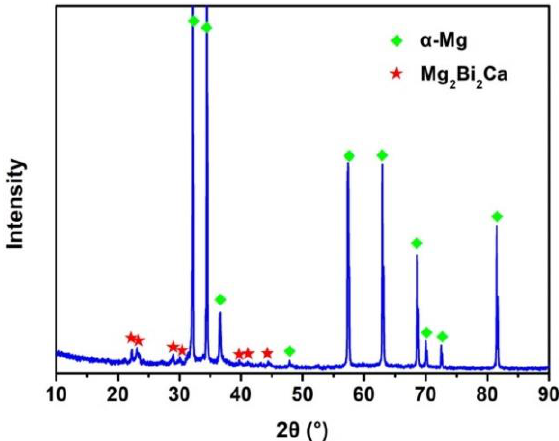
Figure 2. XRD result of the solution-treated BX31 alloy.